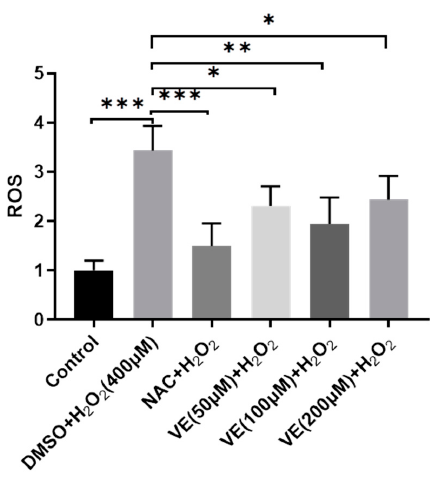
Figure 3. Hepatocytes’ survival rate detected by DCF-DA assay after being treated with 400 μ M H 2 O 2 , with or without pretreatment of various concentrations of vitamin E or NAC. NAC was used as a positive control. One-way ANOVA with Tukey’s test was applied. Data are expressed as mean ± SD; the symbol * means p < 0.05, ** means p < 0.01, and *** means p < 0.001.